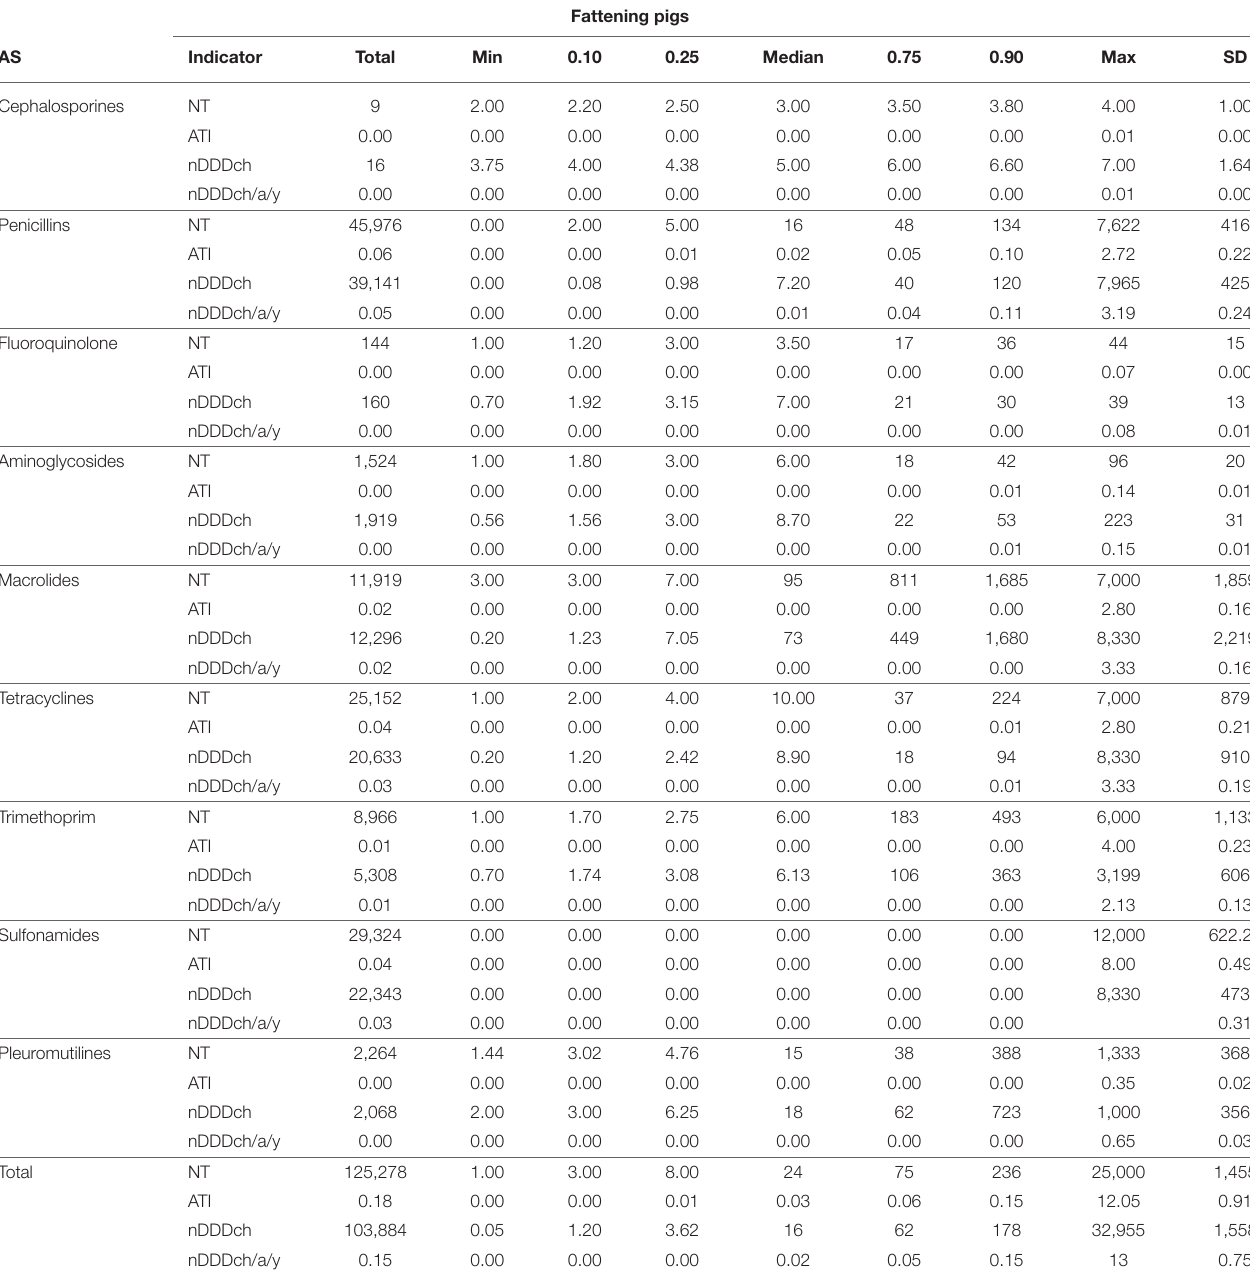
TABLE 4 | Total, minimum (min), median, maximum (max), 10% (0.1), 25% (0.25), 75% (0.75), 90% (0.9) percentiles and standard deviation (SD) of AMU in fattening pigs of the study farms measured using the indicators NT, ATI, nDDDch and nDDDch/animal/year (nDDDch/a/y) displayed by active substance